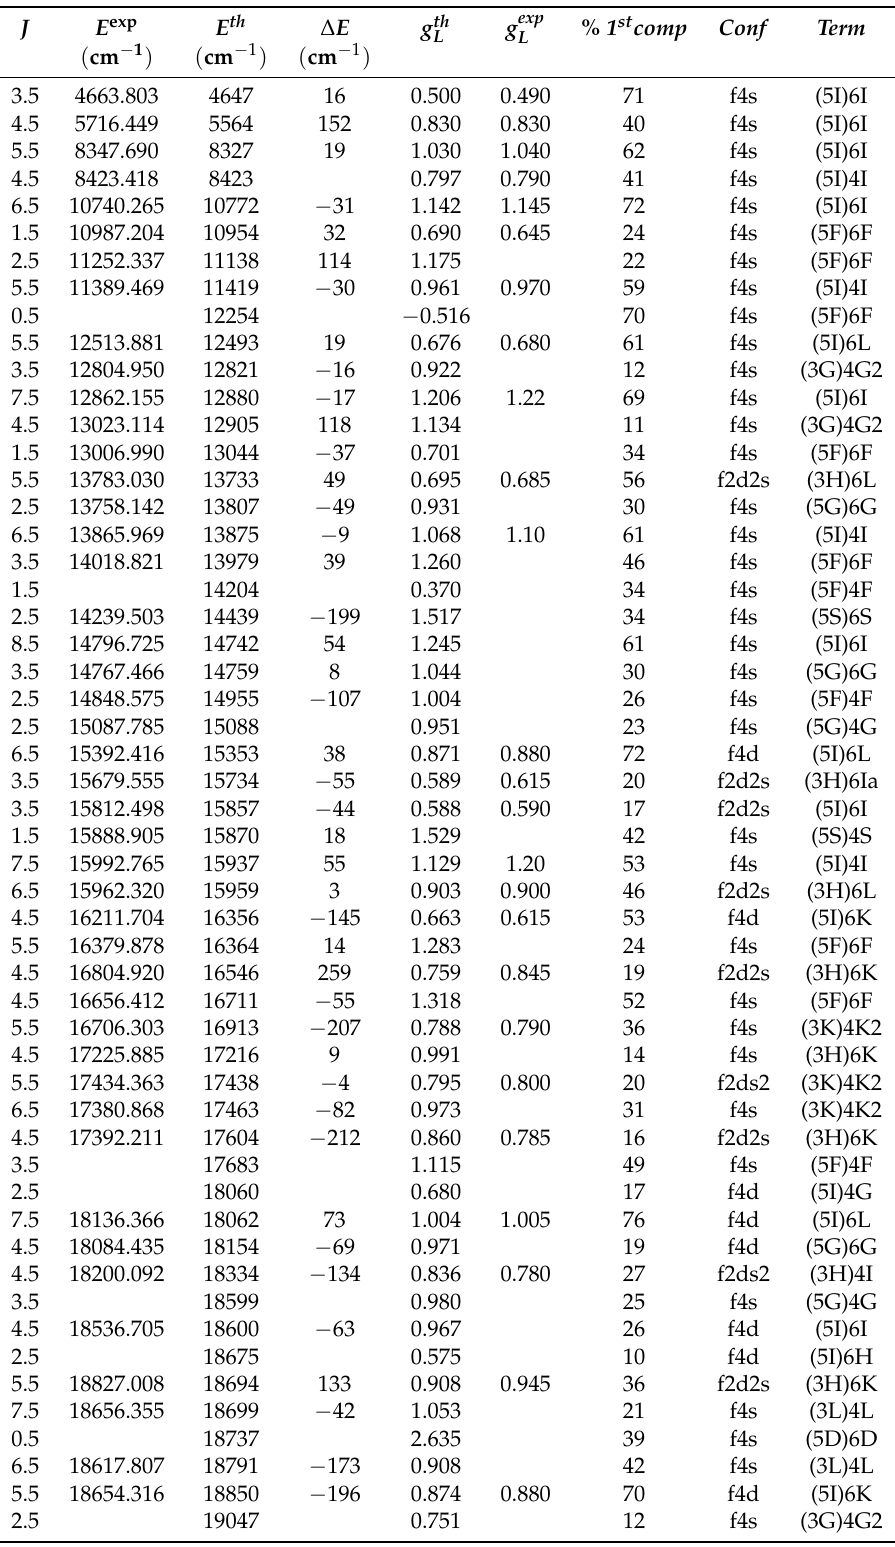
Table 6. Energy levels of U II, even parity with 5 f 2 and 5 f 4 parent configurations. Comparison of experimental energies and Landé factors with values calculated from the parameter set of Table 5. ∆ E = E exp − E th . The percentage, the configuration and the LS name of the leading component in the corresponding configuration are given in the last three